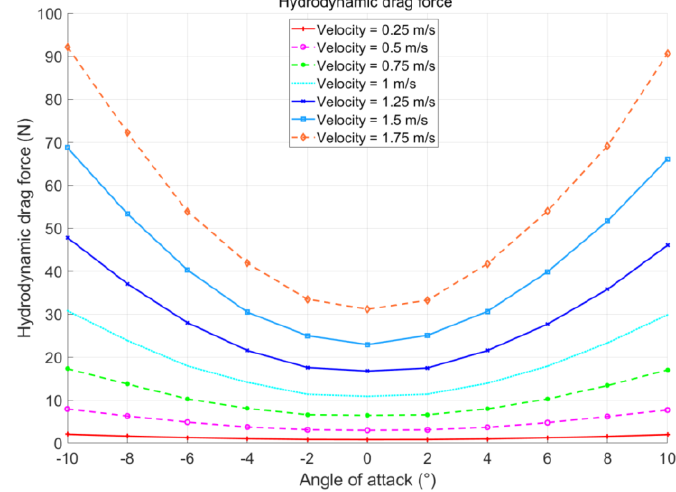
Figure 9. Hydrodynamic drag.